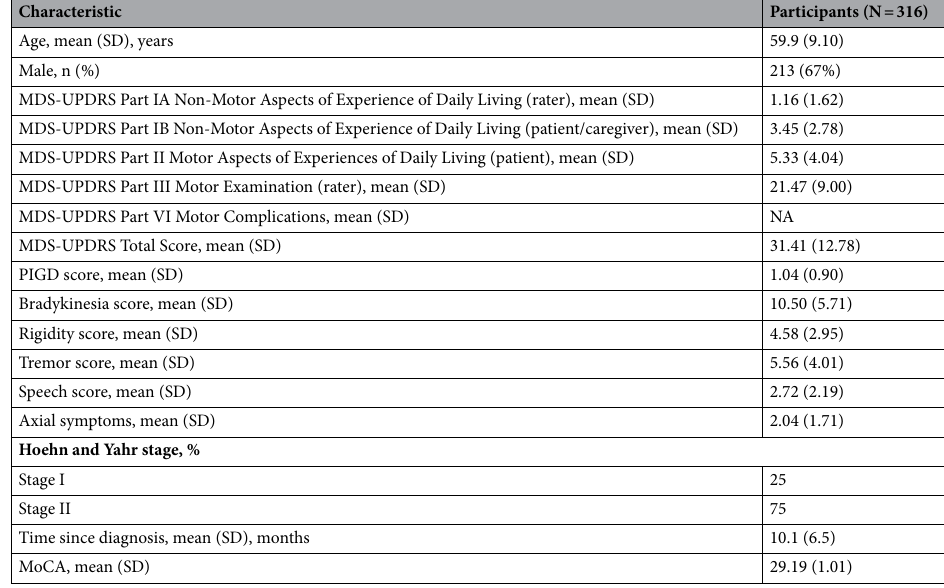
Table 2. Baseline characteristics of participants. MDS-UPDRS Movement Disorder Society—Unified Parkinson’s Disease Rating Scale, MoCA Montreal Cognitive Assessment, NA not applicable, PIGD Postural Instability/Gait Disorders, SD standard